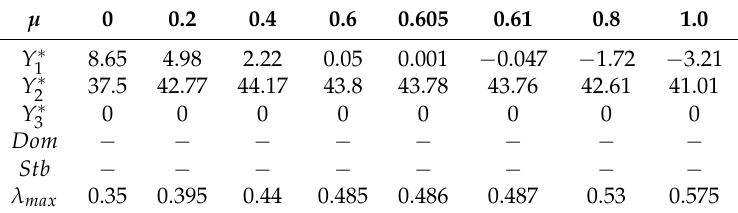
Table 5. The ( 12 ) -profitability